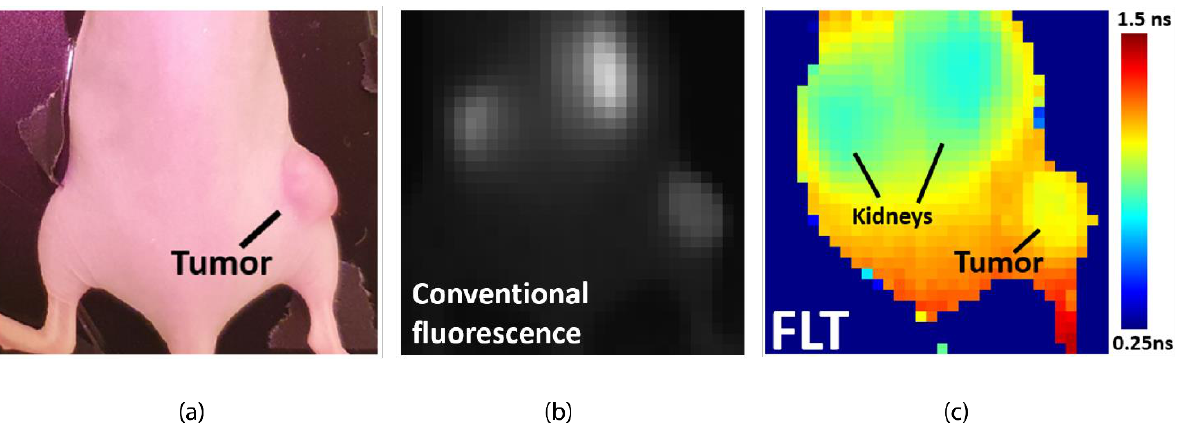
Table 2. Proof-of-concept CAPS camera characteristics.